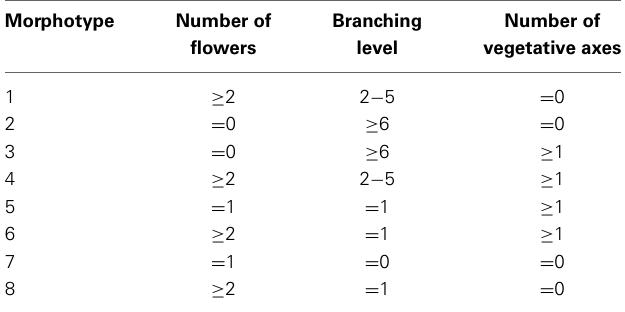
Morphotypes are illustrated in Figure 4